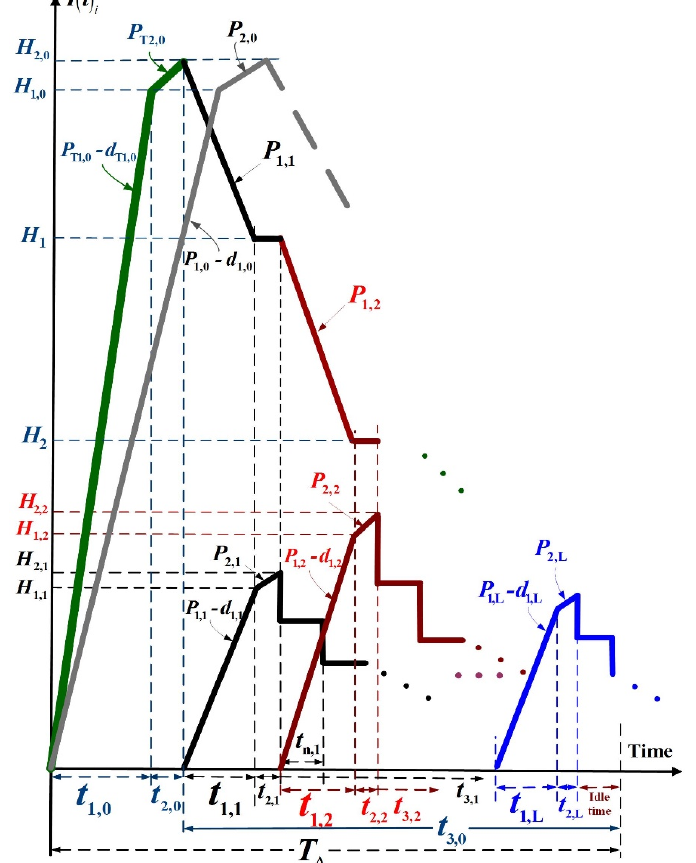
Fig. 1. This study’s inventory level comparing to the same problem without overtime (in